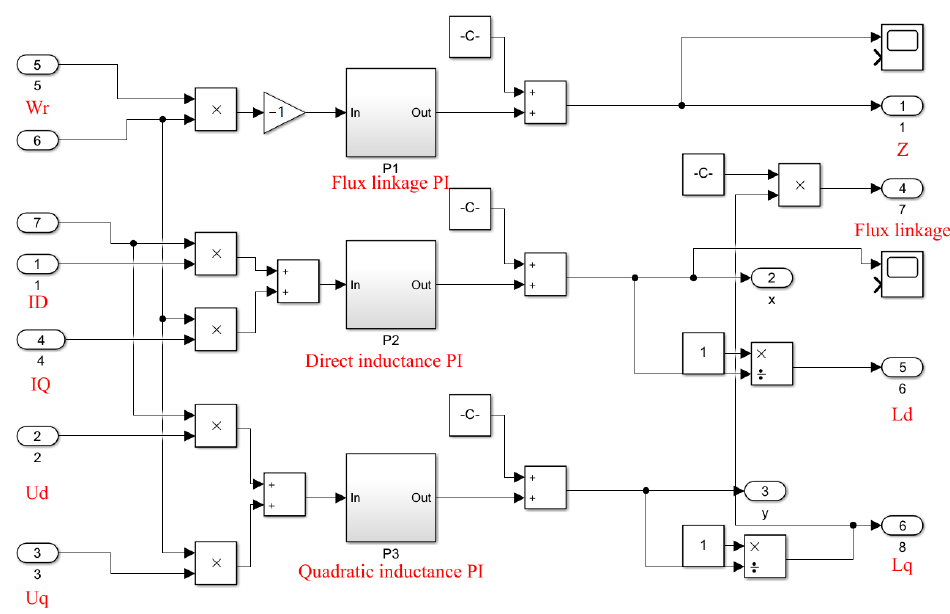
Figure 7. MRAA adaptive rate model.